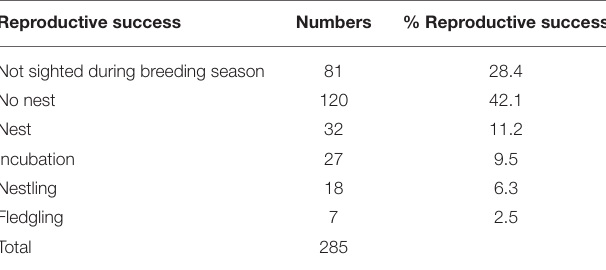
TABLE 5 | Reproductive success of Regent Honeyeaters in the current